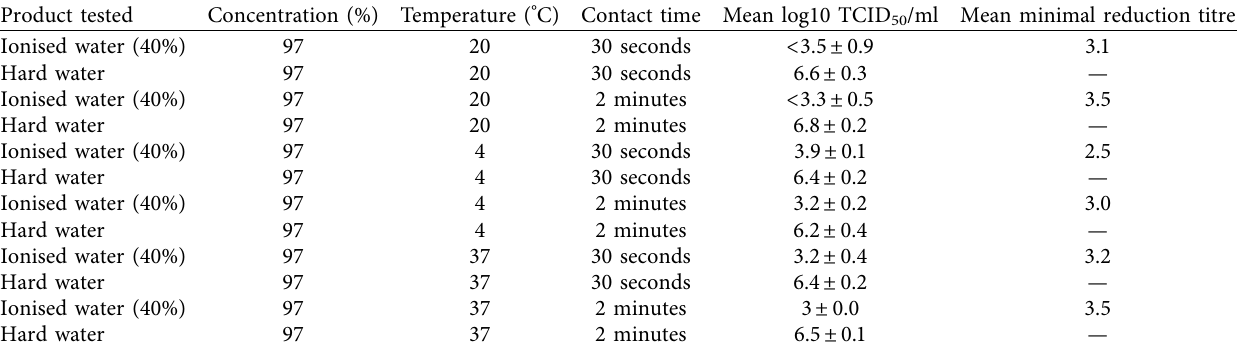
Table 4: Comparative titrations of the SARS-CoV-2 virus after treatment with the ionised water 40% after 30 seconds and two minutes of the contact time at 4 ° C, 20 ° C, and 37 ° C. Product